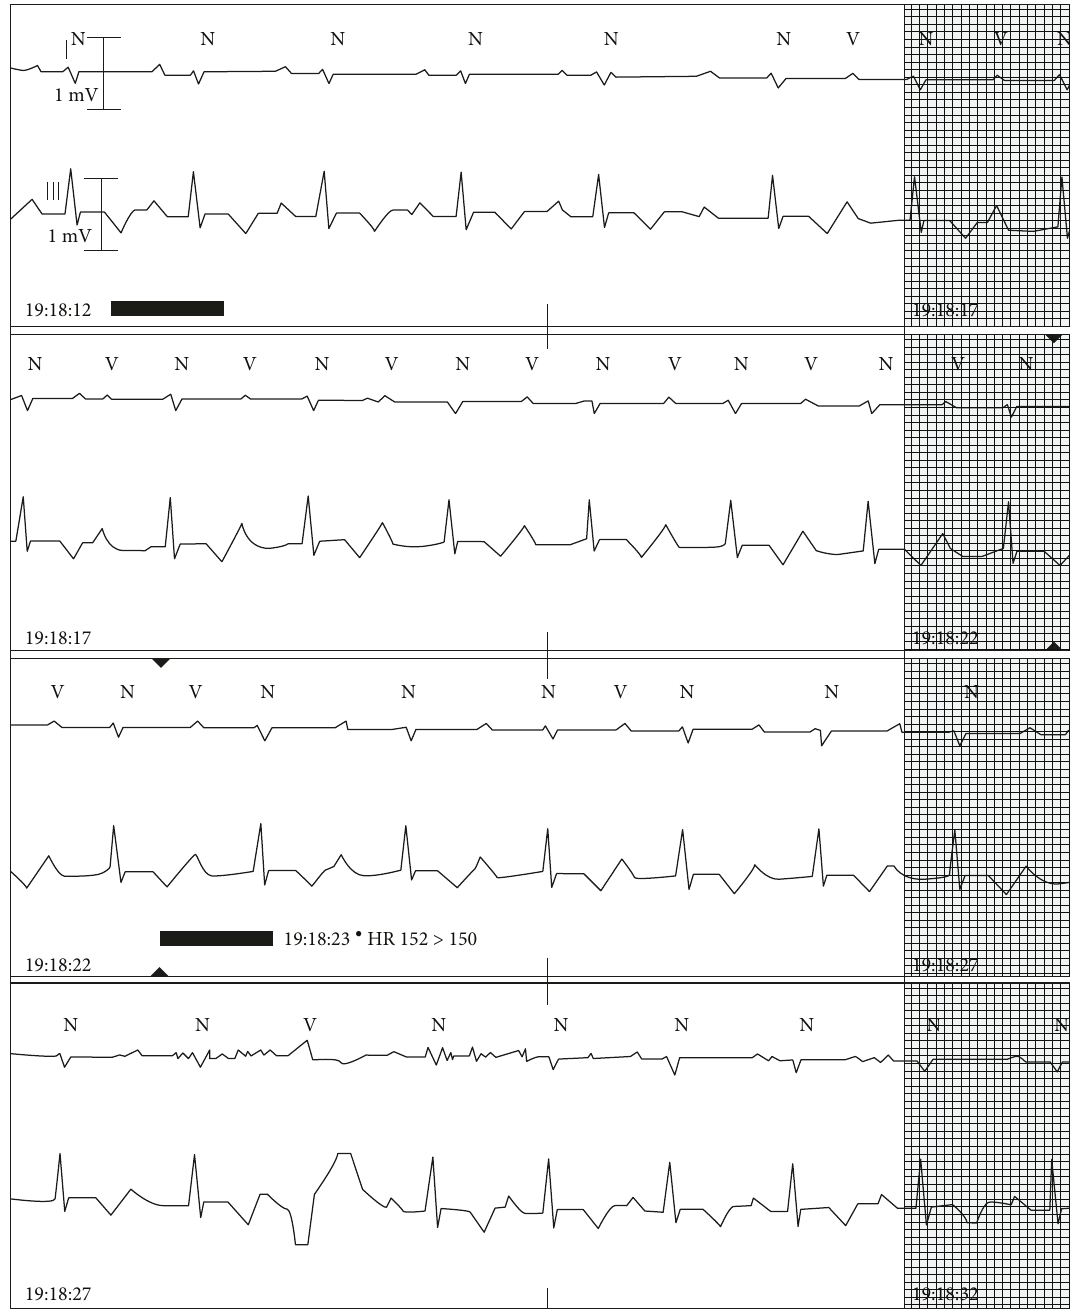
Figure 4: Abrupt change of PR intervals. Abrupt shift from relatively short PR to long PR ( fi rst line) and recurrent shift from long PR to shorter PR (last line). This second shift occurs after a PVC, which is a known phenomenon in which the PVC resets conduction to allow the fast pathway to conduct on the next